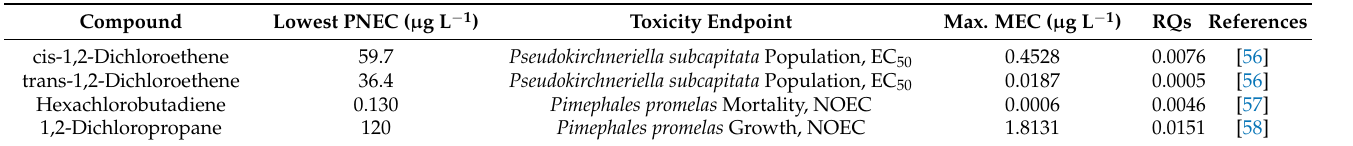
Table 2. Risk quotients (RQs) from predicted no-effect concentration (PNEC) and measured environmental concentration (MEC) for VOCs at Han River Basin.